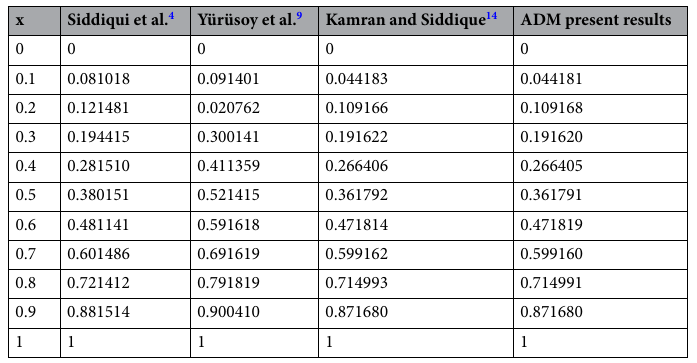
Table 3. Comparison of analytical results for the crisp velocity profile of Couette–Poiseuille flow when β = 0.1, m = 0, p = − 0.5 and α -cut = 1.